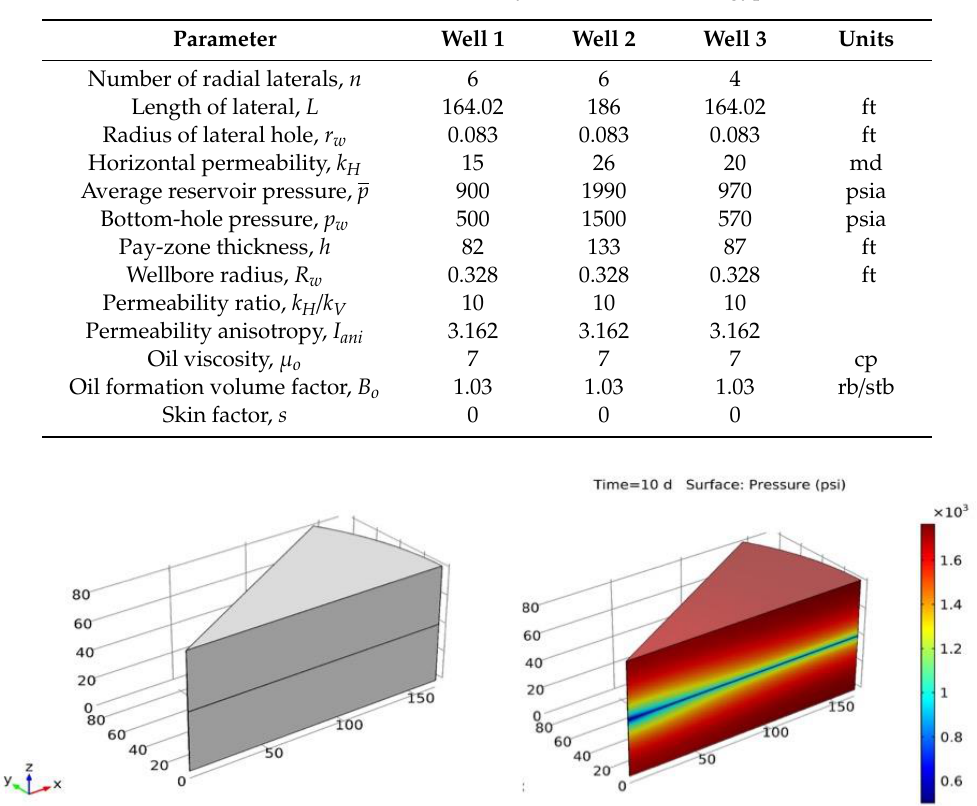
Figure 2. Left : Geometry of case 1 showing one lateral (Phase angle = 60°). Right : pressure profile after 10 days of simulation.